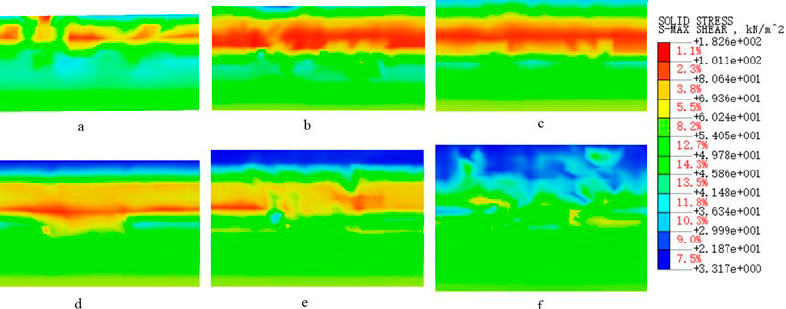
Figure 14. The shear stress of the soil at the cross-section of the rootless slope: ( a ) The slope toe, ( b ) The second row, ( c ) The third row, ( d ) The fourth row, ( e ) The fifth row, ( f ) The sixth row.